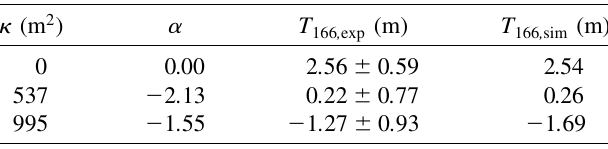
TABLE II. Comparison of experimental and simulated second-order horizontal dispersion values for various sextupole field settings.